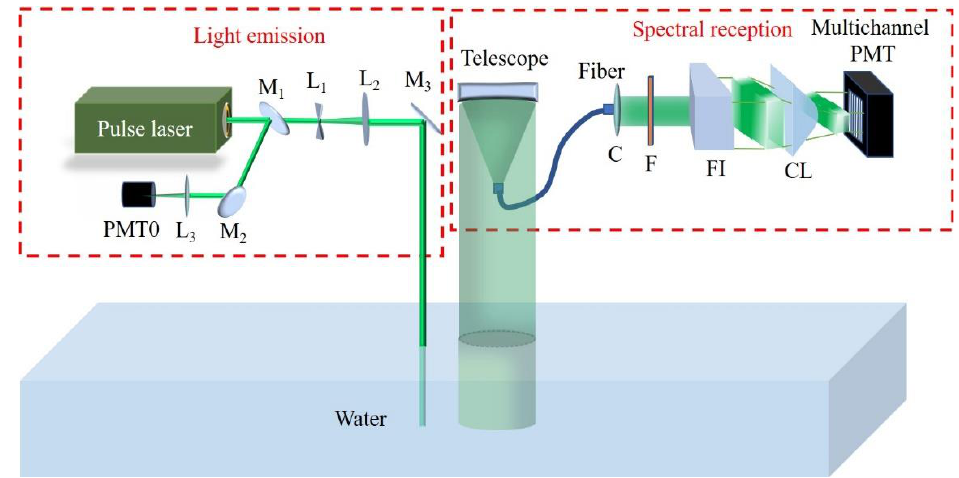
Figure 1. Schematic of the Brillouin spectral method based on a Fizeau interferometer and multichan- nel PMT. The light emitted by the pulse laser is split by M 1 into two parts. One is collected by PMT0 as the reference beam to monitor the energy changes. The other part, after the beam expander system, directly enters the water to produce a scattering light. Subsequently, the 180 ◦ backscattered light is first collected by a Cassegrain telescope and transmitted through an optical fiber. After collimation, the light successively passes through a narrowband filter (F) and the Fizeau interferometer (FI), producing an interference fringe. The fringe is then sharpened by the cylindrical lens (CL) and finally detected by the multichannel PMT. (M i and L i indicate the mirrors and lenses, respectively, and C is the fiber collimator). Table 1. Design parameters of the system.